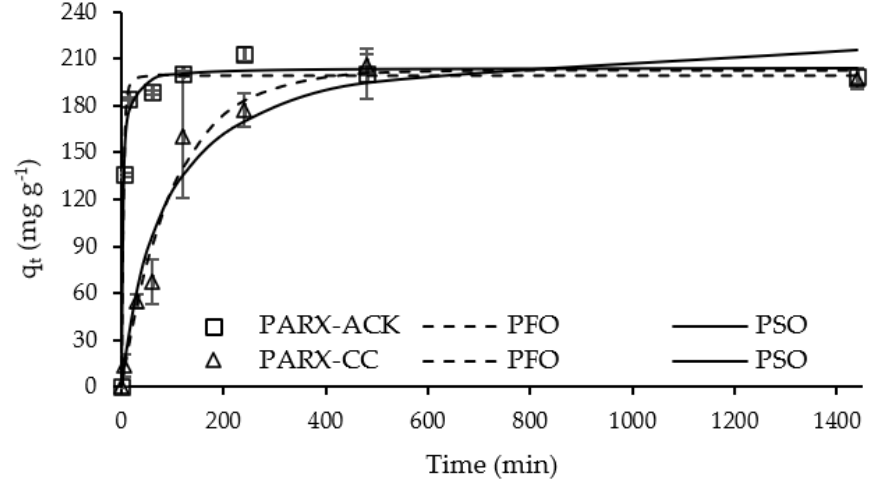
Figure 6. Kinetic curves of PARX adsorption for ACK and CC carbons (Adsorbent mass = 10 mg; PARX initial concentration = 100 mg L − 1 ; Solution volume = 25 mL; Solution initial pH = 5.5). Dots—experimental data; Lines—kinetic models’ adjustment.